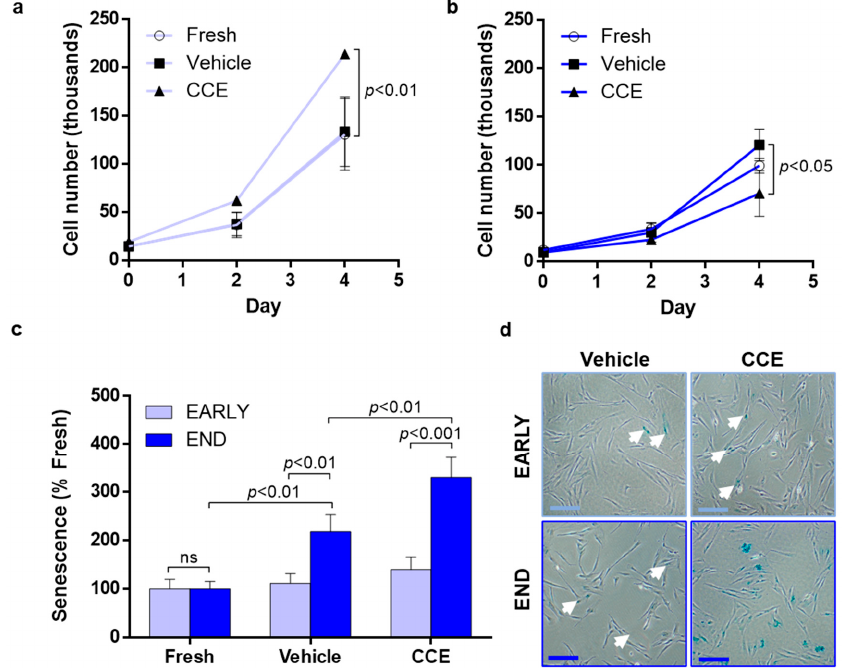
Figure 3. Proliferation and senescence in EARLY and END models. ( a ) EARLY SMC were cultured in full growth medium for up to 4 days, and proliferation was measured using trypan blue exclusion and live cell counts. ( b ) Parallel cultures were maintained and counted from END SMC. ( c ) SMC were cultured for 48 h in full growth medium before being fixed, and senescent cells were detected by positive β -galactosidase staining. ( d ) Representative images taken at ×40 magnification; scale bar = 200 µm, closed arrows indicate areas of positive staining. All n = 3, significance assessed using repeated-measures two-way ANOVA with Sidak’s multiple comparison post hoc test.